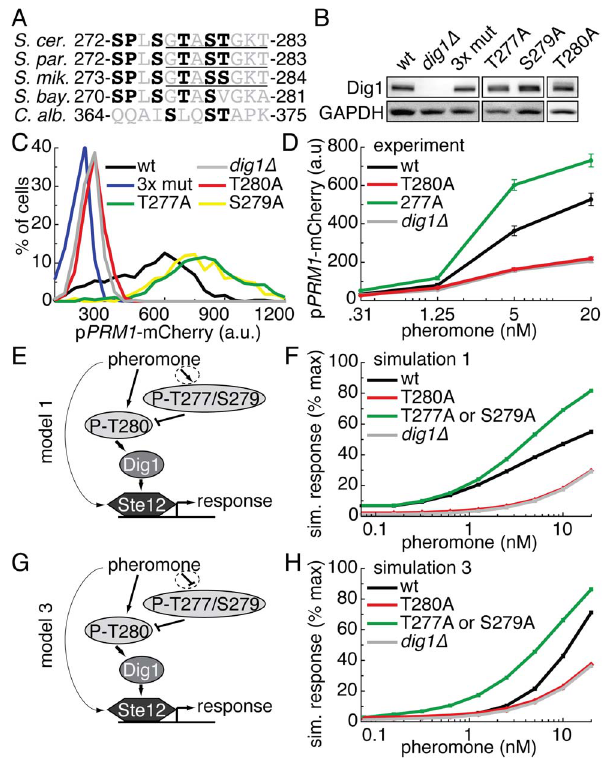
Figure 4. Opposing phenotypes in Dig1 phospho-mutants. A. Alignment of an 12-amino acid sequence, part of a tryptic phospho- peptide, in 5 yeast species. Possible phosphorylation sites (serines and threonines) and minimal MAPK consensus sequences (S/T,P) are in bold. The ‘‘TAST’’ sequence in S. cer. Dig1 falls in the variable region of a bioinformatically predicted ATP/GTP binding motif (p-loop, underlined). B. Western blots of lysate from yeast strains containing the indicated alleles of Dig1-YFP probed with rabbit anti-Dig1 and anti-GAPDH. 3xmut is Dig1 T277A,S279A,T280A . C. Histograms of the single cell pheromone response measured by p PRM1 -mCherry fluorescence. Cells (n . 500 cells) were treated with 20nM alpha factor for 3 hrs followed by cycloheximide for 2 hrs, imaged by fluorescent microscopy, and quantified with Cell-ID. D. Dose responses of cells treated with the indicated concentrations of pheromone as described in C. The means of the unimodal distributions are plotted. Error bars depict the standard error of the mean. E. Cartoon of model 1, in which pheromone induces phosphorylation of all residues. F. Simulation of model 1 across a dose response of pheromone. G. Cartoon of model 3, in which pheromone induces the dephosphorylation of T277/S279 and the phosphorylation of T280. H. Simulation of model 3 across a dose response of pheromone.